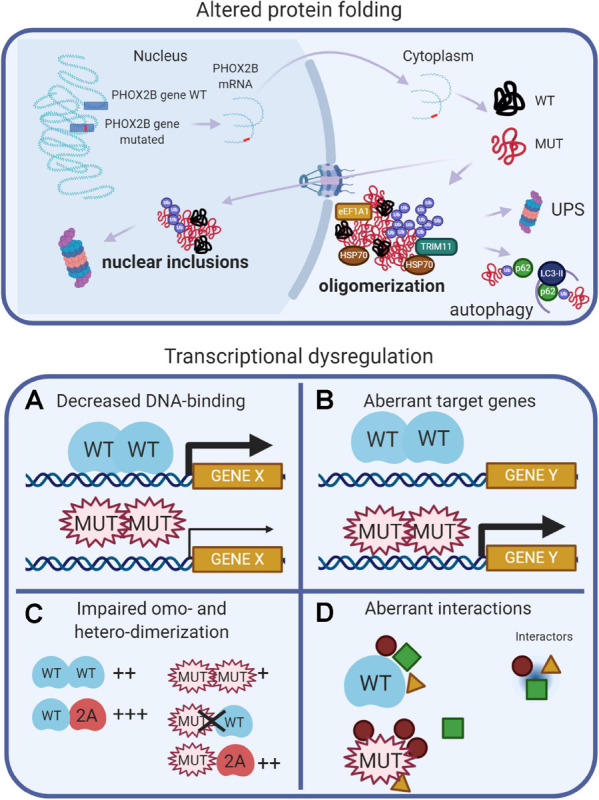
(Created with BioRender.com). Molecular basis of CCHS. The upper panel shows that, in CCHS, mutations affect one copy of the PHOX2B gene. Transcription and translation give rise to two proteins, wild-type and mutated. Misfolded mutant proteins form aggregates in the cytoplasm, also sequestering wild-type proteins, and may be bound by molecular chaperones (heat shock proteins, HSPs) in an attempt to refold them. Alternatively, unsuccessful folding can facilitate their ubiquitination (Ub), a process involving ubiquitin ligases such as TRIM11, and recognition by the proteolytic machinery (UPS, Ubiquitin Proteasome System). Autophagy can participate in the removal of PHOX2B protein aggregates. A fraction of the mutant proteins can enter the nucleus, aggregate and form nuclear inclusions or induce transcriptional dysregulation (lower panels) by: (A) decreasing DNA binding, limiting PHOX2B transcriptional activity; (B) inducing aberrant genes expression; (C) decreasing the formation of homodimers and the interaction with the paralog PHOX2A; (D) aberrant interactions with transcriptional cofactors; some of these might be inappropriately enhanced, whereas others might be lost or unchanged.